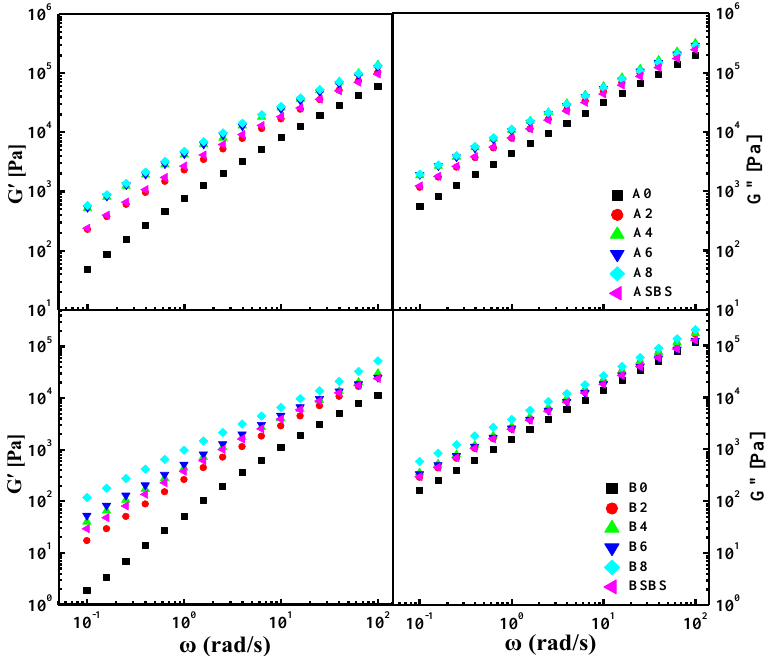
Figure 3. Effects of loading frequency on the storage and loss modulus of the base and the SBS latex-modified asphalts.